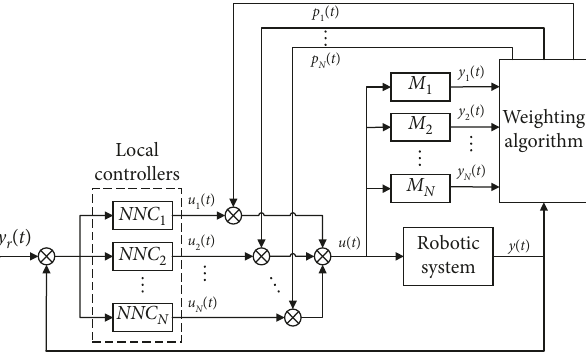
Figure 1: Concise block diagram of the WMNNAC